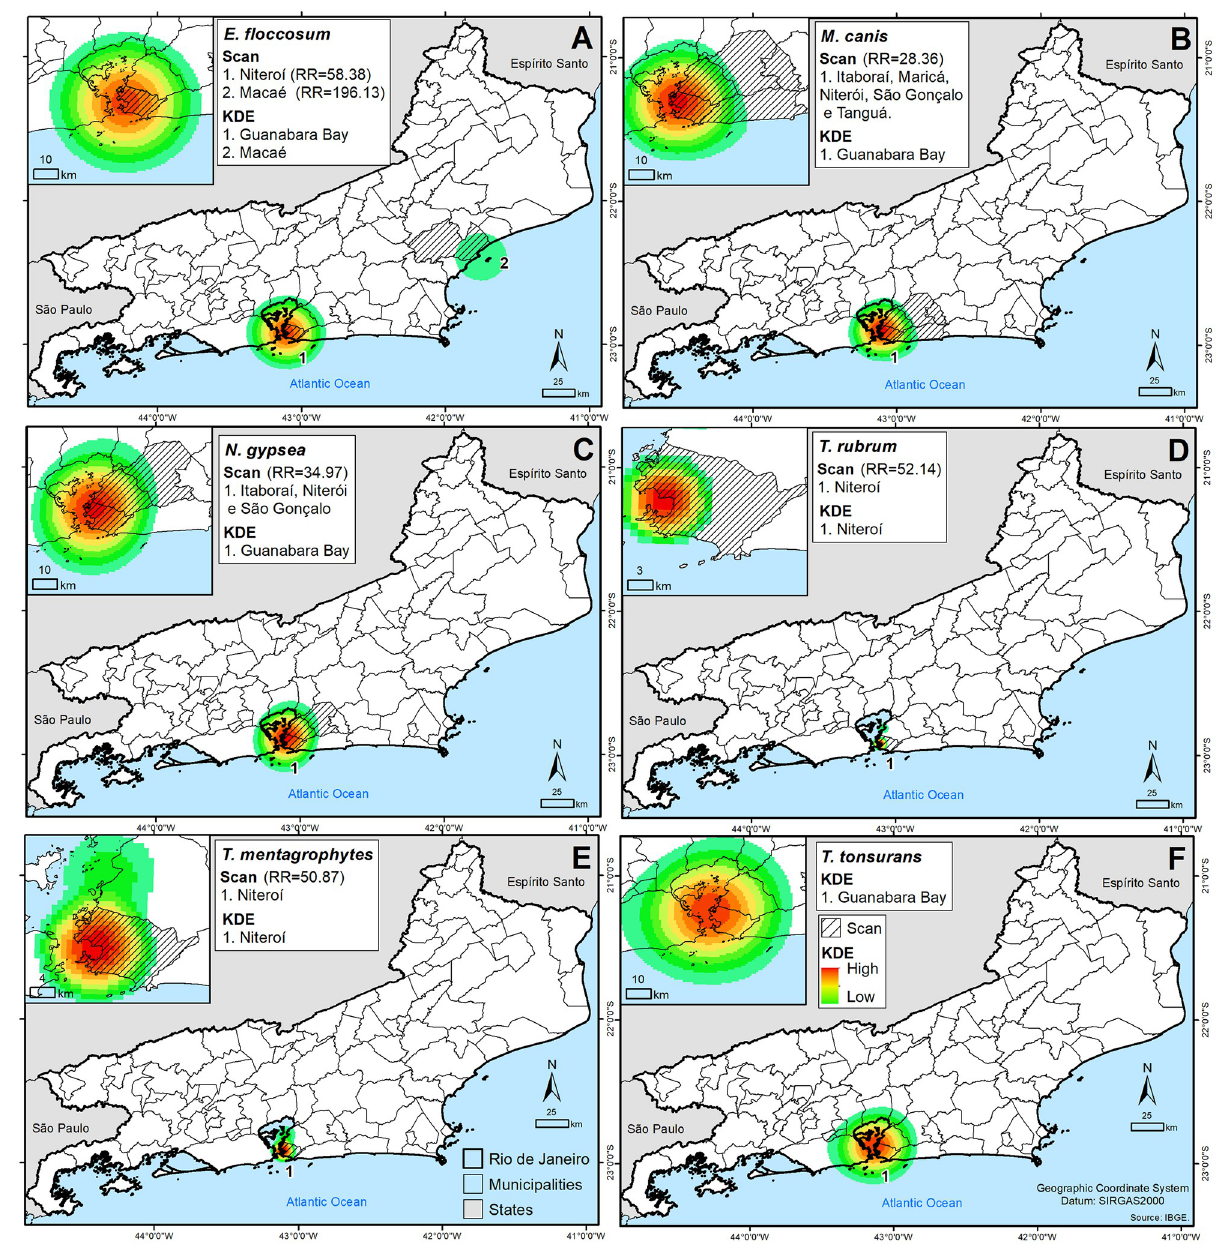
Fig 4. Application of EDK and Scan in monoinfections (A) Epidermophyton floccosum , (B) Microsporum canis , (C) Nannizzia gypsea , (D) Trichophyton rubrum , (E) Trichophyton mentagrophytes and (F) Trichophyton tonsurans in Rio de Janeiro state. (https://www.ibge.gov.br/en/ geosciences/downloads-geosciences.html).